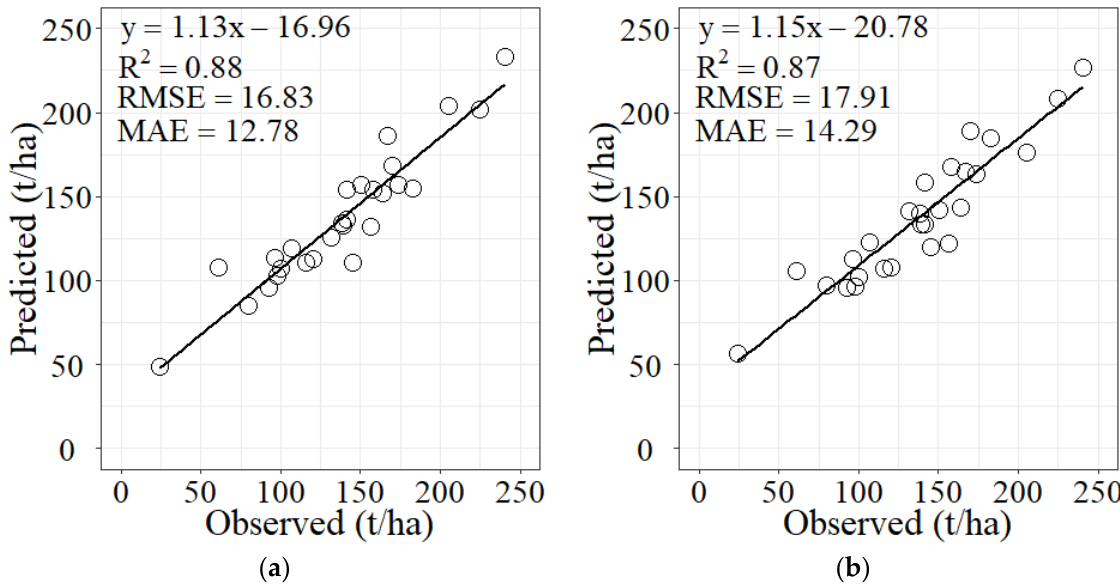
Figure 5. Scatter plots of the predicted AGB by regression kriging against the observed AGB values in Wangyedian using: ( a ) Landsat 8 and ( b ) Landsat 9.